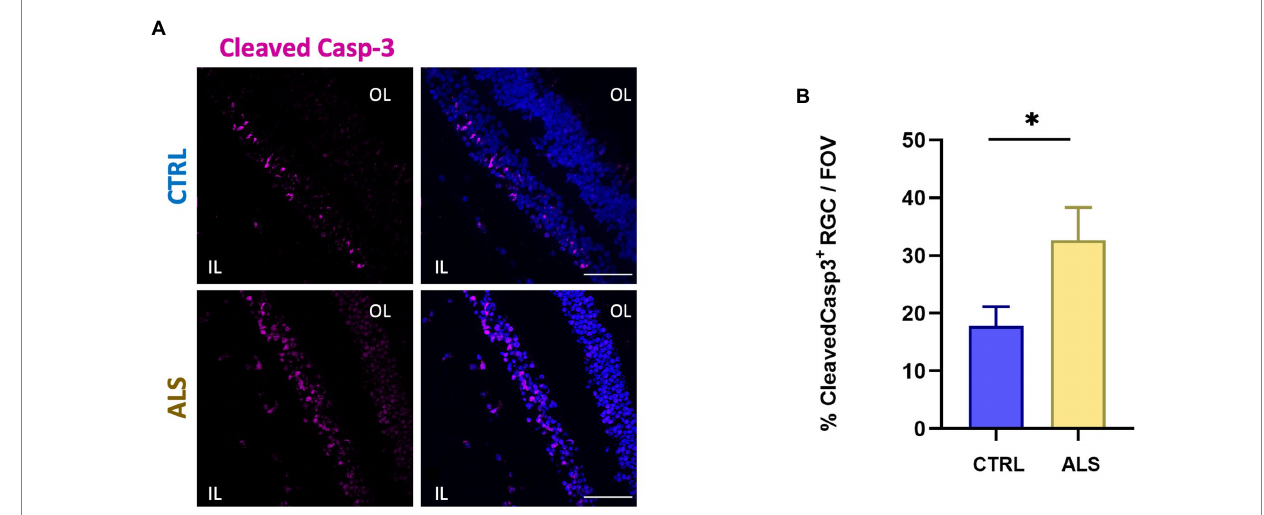
FIGURE 3 Human ALS retina show neurodegeneration in the Ganglion Cell Layer. (A) Representative immunostaining of anti-cleaved Caspase-3 (magenta) and Hoechst for nuclei visualization (blue) in retinal slices from ALS patients and control individuals; scale bar 50 μ m. (B) Bar chart displaying the percentage of cleaved Caspase-3 positive cells in the ganglion cell layers (IL, inner layer; * p < 0.05 ALS vs. CTRL; Mann–Whitney U test; ALS n = 50/5 fields/ individuals; CTRL n = 51/6 fields/individuals).